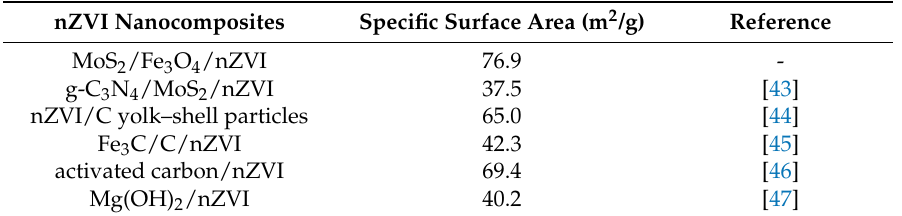
Table 1. Specific surface areas of different nZVI nanocomposites.